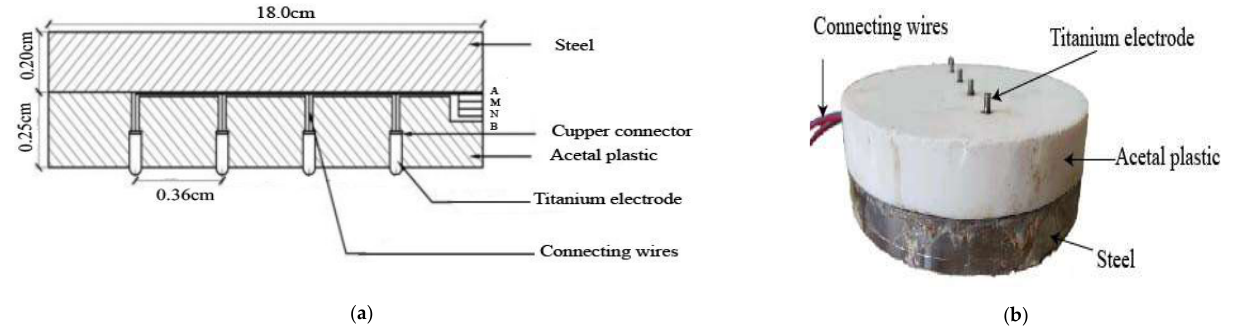
Figure 1. Resistivity plate loading device. ( a ) A section of the laboratory resistivity loading plate and ( b ) a picture of the resistivity loading plate.